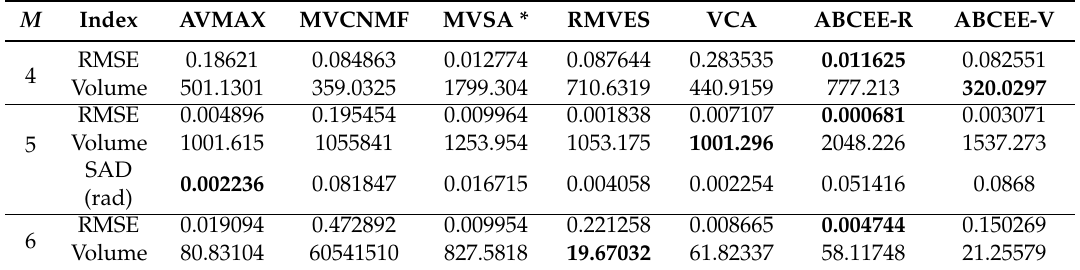
Table 1. Experimental results for synthetic hyperspectral dataset